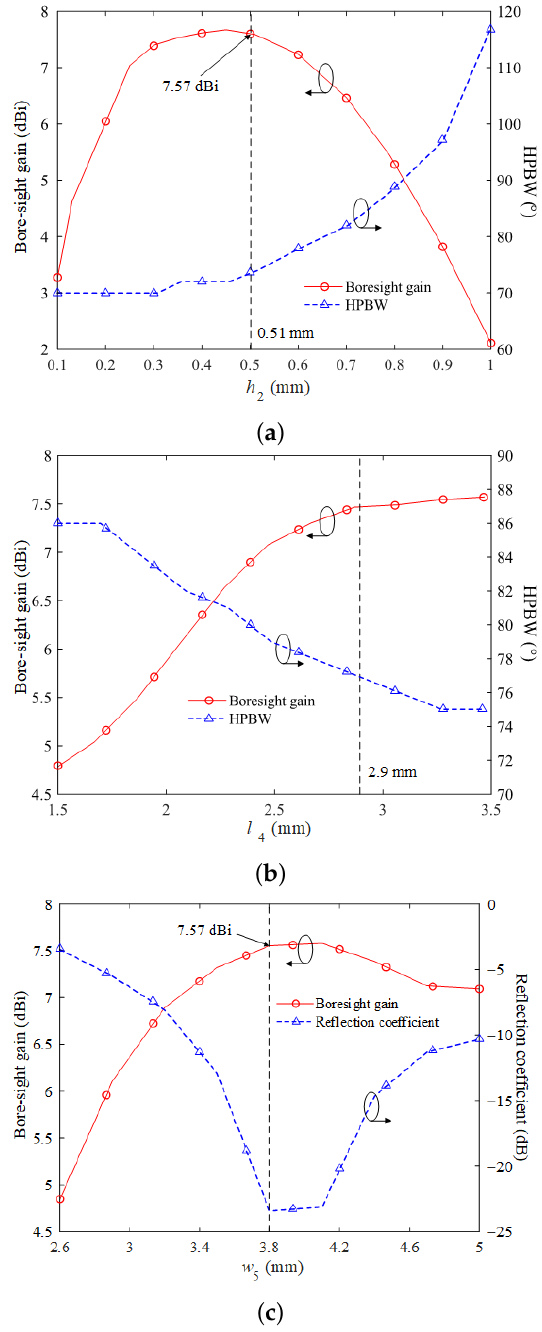
Figure 2. Simulated bore-sight gain, HPBW, and reflection coefficient according to the parameters: ( a ) h 2 , ( b ) l 4 , and ( c ) w 5